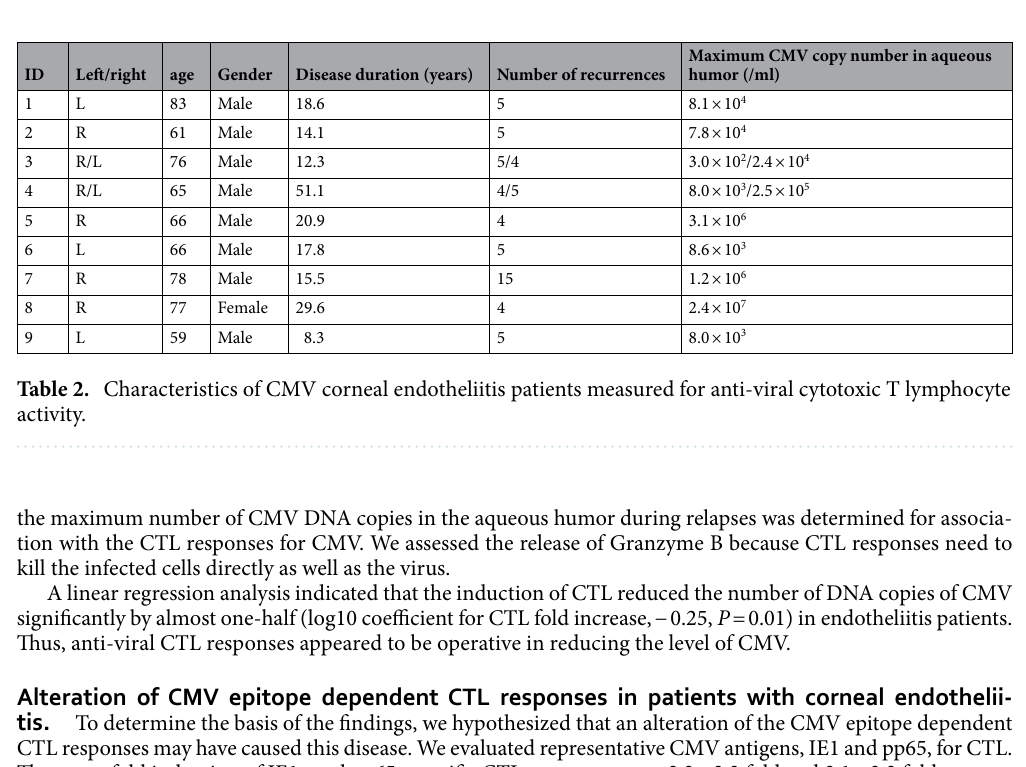
Maximum CMV copy number in aqueous humor